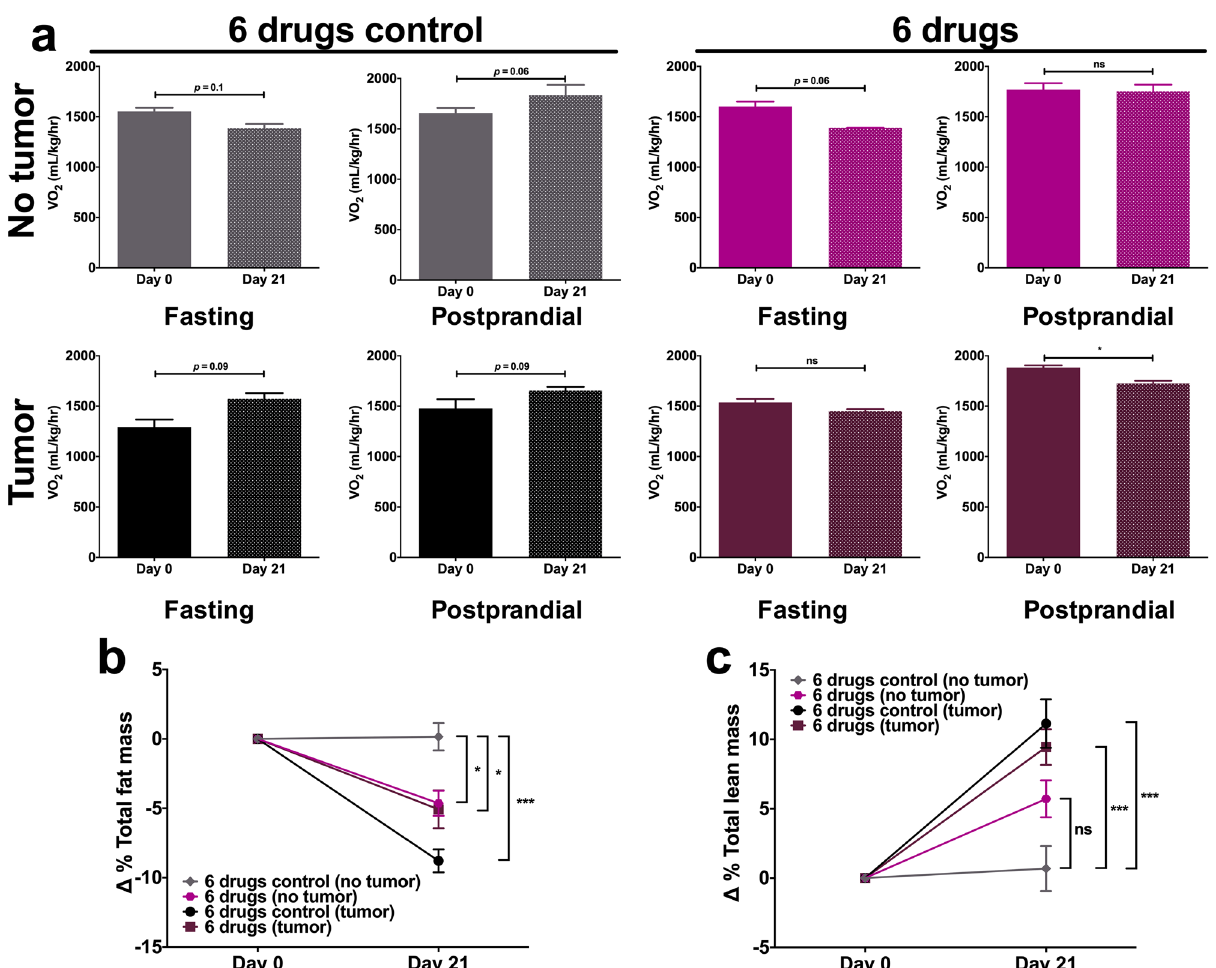
from non-tumor and tumor-bearing mice at days 0 and 21 of treatment, during a 24 h period composed of 12 h of fasting and 12 h of postprandial. ( b,c ) Delta of total fat ( b ) and lean ( c ) masses percentages at days 0 and 21 of evaluation . Data are expressed as means ± s.e.m. N = 1 independent experiment, 10 mice/group. Statistical analyses were performed with one-way ANOVA with Dunnet correction. 6 drugs: Orlistat + lonidamine + DON + growth hormone + insulin + indomethacin; ns: non-significant; *p < 0.05 ; ***p < 0.001